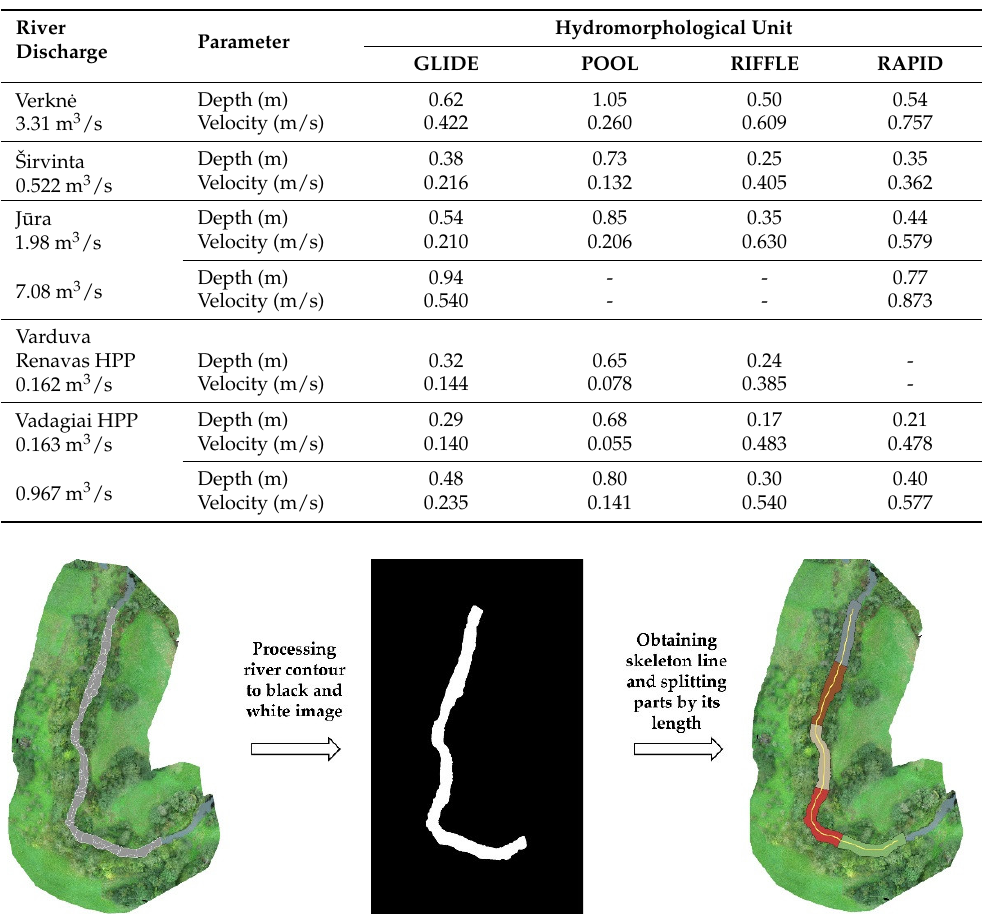
Table 2. Average values of depth and streamflow velocity for different hydromorphological units in studied river stretches.